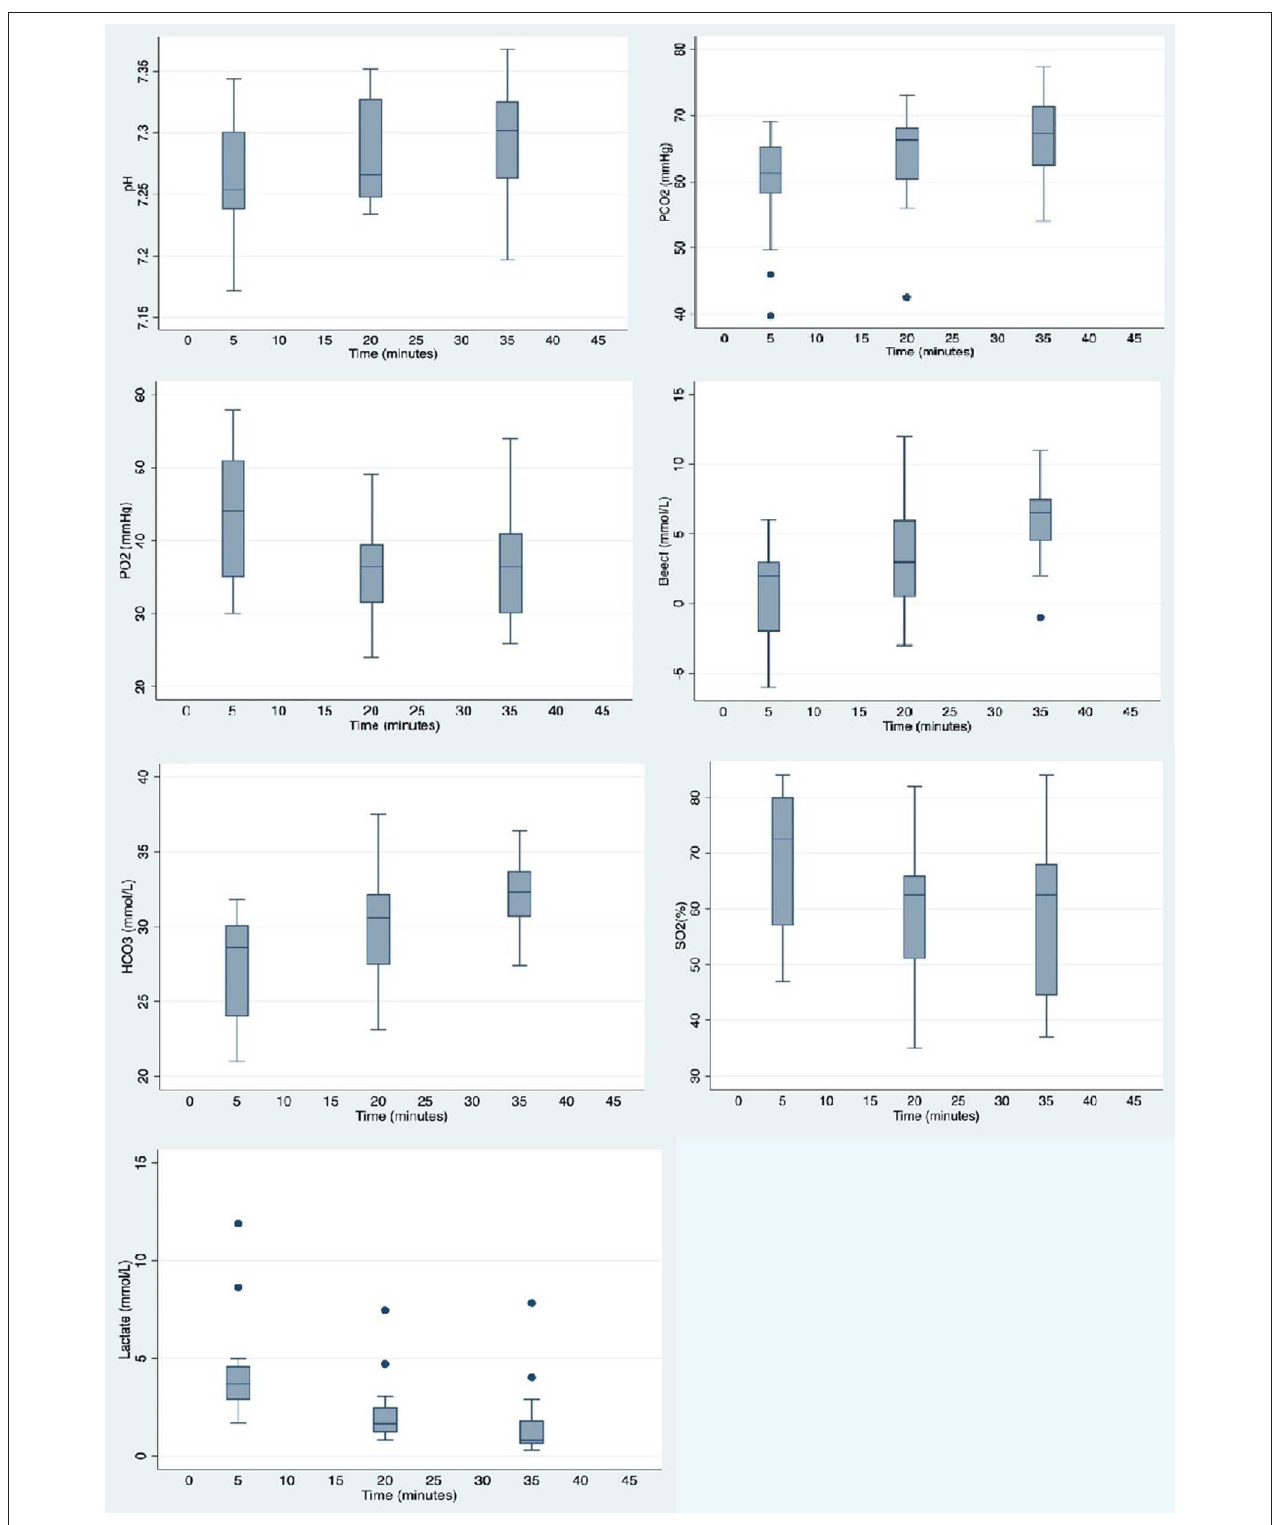
FIGURE 3 | Box plots showing distribution of arterial blood gas values measured at 15min intervals in warthogs (Phacochoerus africanus) immobilized with etorphine, azaperone, and butorphanol. The box represents the interquartile range (25th and 75th percentile) with the horizontal bars inside the box representing median values. The bars represent the lower and upper adjacent values, and outside values are represented by